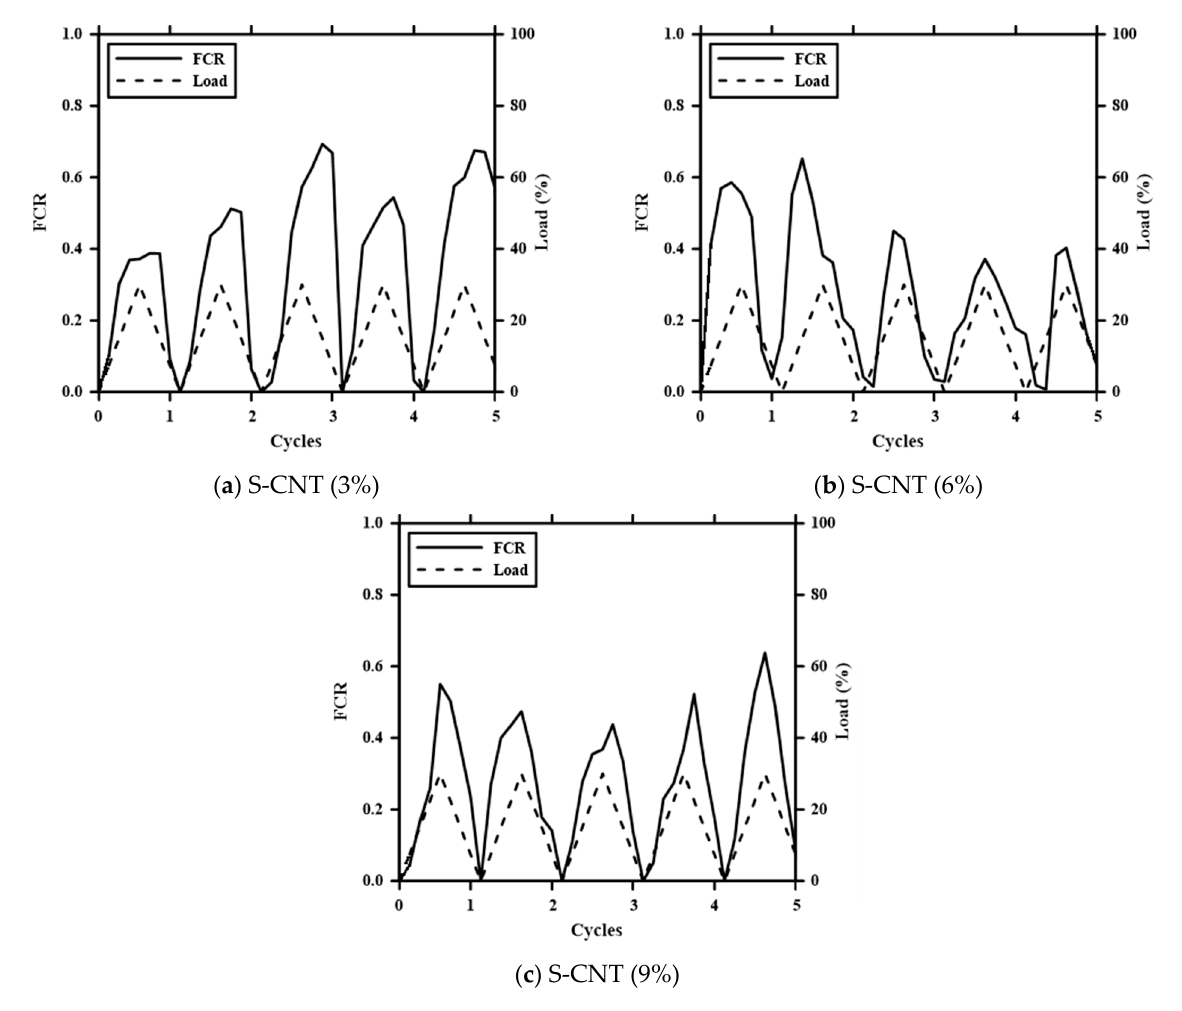
Figure 11. FCR according to S-CNT: ( a ) S-CNT (3%); ( b ) S-CNT (6%); ( c ) S-CNT